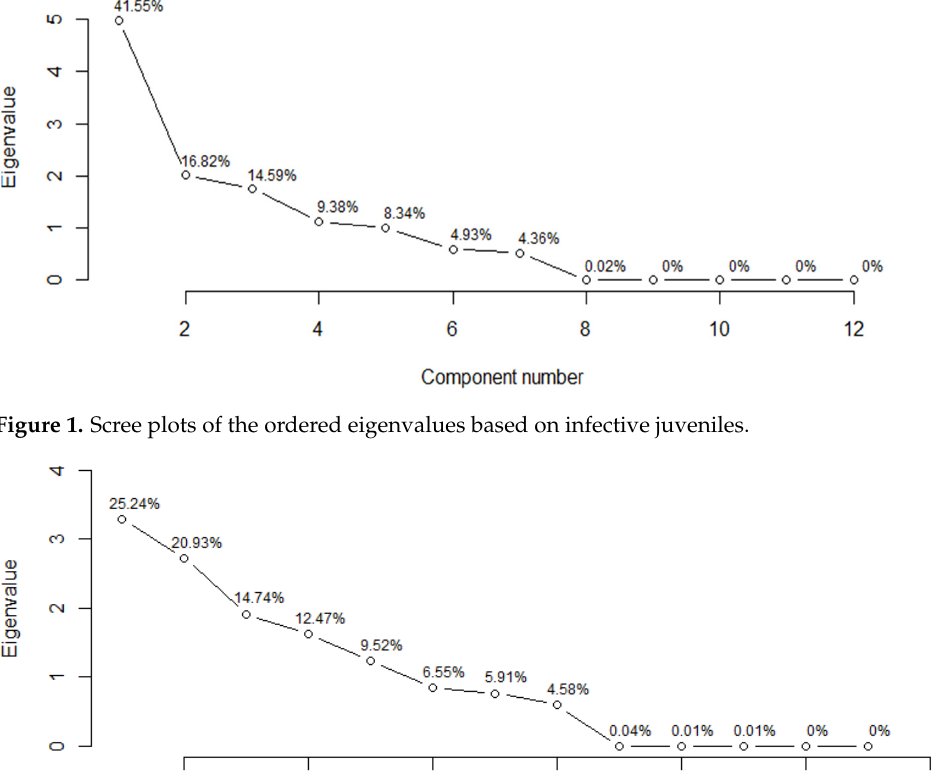
variables on the principal components. The vectors representing the original variables did not extend to the edges of the unit circle; thus, they were all moderately represented by the first two principal components making up the coordinate system. When analyzing the angles between the juvenile vectors, it can be noted that the variables total body length and c ( 𝑟 (cid:3404) 0.938 ), total body length and b ( 𝑟 (cid:3404) 0.924 ), and b and c ( 𝑟 (cid:3404) 0.905 ) were strongly positively correlated, whereas the variables distance from anterior end to end of pharynx and b ( 𝑟 (cid:3404) 0.0314 ), maximum body width and D ( 𝑟 (cid:3404) 0.0673 ), tail length and D ( 𝑟 (cid:3404) 0.0837 ), and anal body width and a ( 𝑟 (cid:3404) 0.0900 ) were not significantly correlated. On the other hand, for males, there was a strong significant correlation between the variables total body length and b ( 𝑟 (cid:3404) 0.889 ), maximum body width and a ( 𝑟 (cid:3404) (cid:3398)0.788 ), total body length and c ( 𝑟 (cid:3404) 0.783 ), b and c ( 𝑟 (cid:3404) 0.766 ), and tail length and E ( 𝑟 (cid:3404) (cid:3398)0.733 ), whereas spicule length and c ( 𝑟 (cid:3404) (cid:3398)0.00458 ), maximum body width and c ( 𝑟 (cid:3404) 0.00500 ), distance from anterior end to excretory pore and a ( 𝑟 (cid:3404) (cid:3398)0.00531 ), maximum body width and b ( 𝑟 (cid:3404) 0.00616 ), and gubernaculum length and b ( 𝑟 (cid:3404) (cid:3398)0.00974 ) were not significantly correlated (Tables 6 and 7). Figure 3. Principal component analysis of morphometric variables for infective juveniles.